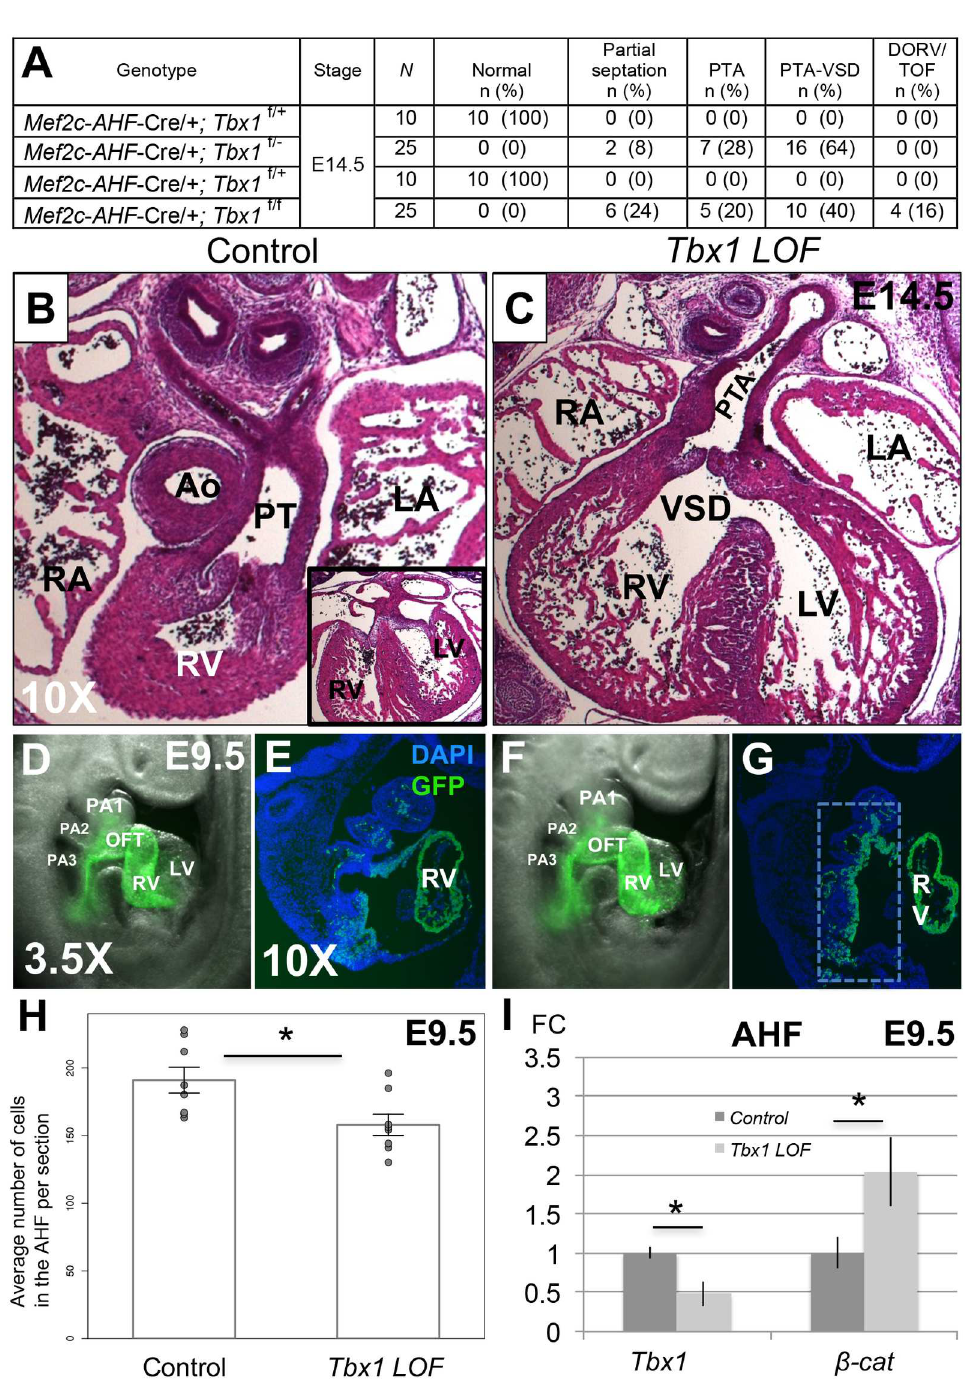
Fig 2. Congenital heart defects in Tbx1 LOF embryos. (A) Heart phenotype analysisof Tbx1 LOF embryos at E14.5 generatedfrom two different crosses. PTA-VSD refers to a PTA associatedwith a ventricular septal defect (VSD) whilePTA refers to hearts that did not show a VSD. Partial septationin Tbx1 LOF embryos means a PTA with presenceof a short septum at some level of the OFT and completeseptation betweenthe ventricles. N = total number of hearts observedper group. Significancebetween Tbx1 LOF and controls calculatedby Fisher’s exact test (p < 0.001). Note that Mef2c-AHF-Cre;Tbx1 flox/flox embryos had additionalphenotypes (three with doubleoutlet right ventricle, DORV and one with tetralogy of Fallot, TOF, as indicated); (B) H&E histological sectionsof the heart of a control embryo at E14.5, with a typical ventricular septum is shown in the inset on the lower right part of the image. (C) Tbx1 LOF embryo with a PTA-VSD. (D) Mef2c-AHF-Cre lineagetracing